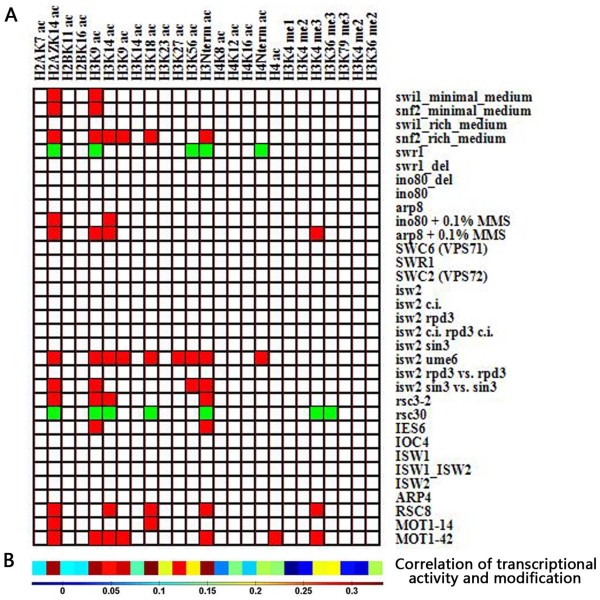
The interactions between ATP-dependent chromatin remodeling and covalent modification of histones. (A) Rows represent ATP-dependent chromatin remodelers, and columns represent histone modifications. Ac represents acetylation, while me indicates methylation (e.g. me2 indicates dimethylation). For each remodeler-modification pair, if it satisfies P < 0.05 in both statistical tests, it was colored red (positive regulation by the remodeler) or green (negative regulation by the remodeler), otherwise it was colored white. (B) The correlation between transcriptional activity [26] and modification enrichment at promoters for the histone modification indicated in each column. Colors indicate Pearson correlation coefficients.